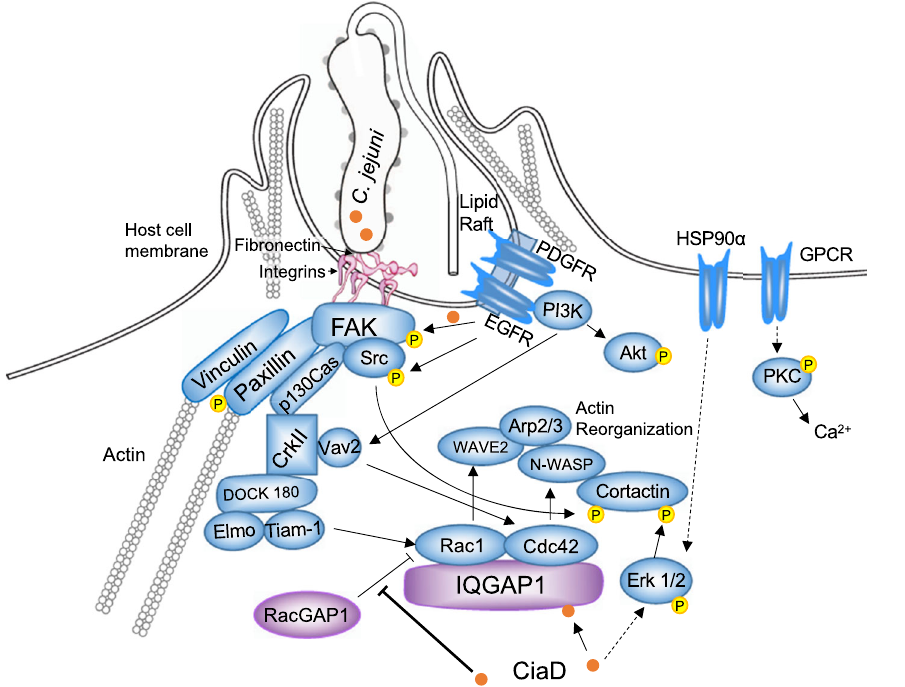
Fig. 6 Proposed model of the role of the C. jejuni effector protein CiaD in the process of internalization based on experimental results and other published literature. The fi rst step in cellular invasion is the adherence of C. jejuni to the host fi bronectin via the CadF and FlpA adhesins (gray dots on the C. jejuni ). Next, the C. jejuni fl agellar-dependent effector proteins, including CiaD (orange circles), are delivered to the cytosol of the host cell. The combined action of bacterial adherence and the secreted effector proteins triggers activation (phosphorylation) of the focal adhesion components FAK, Src, and paxillin, which recruits vinculin. Focal adhesion signaling is integrated into actin remodeling signaling through the proteins p130Cas, CrkII, DOCK 180, Elmo, and Rac1. Cytosolic CiaD facilitates the activation of the Erk 1/2 signaling pathway, which results in the phosphorylation of cortactin. IQGAP1 serves as a binding partner of CiaD, and it facilitates the activation of Rac1 and Cdc42, further promoting actin reorganization and bacterial uptake through the proteins WAVE2, N-WASP, and Arp2/3. CiaD promotes Rac1 activation by excluding RacGAP1 from the IQGAP1 complex, preventing the deactivation of Rac1. Other literature has also provided support for the roles of EGFR, PDGFR, PI3K, Akt, HSP90 α , GPCRs, PKC, Vav2, and Tiam-1 in coordinating bacterial uptake. Purple indicates the fi ndings from this